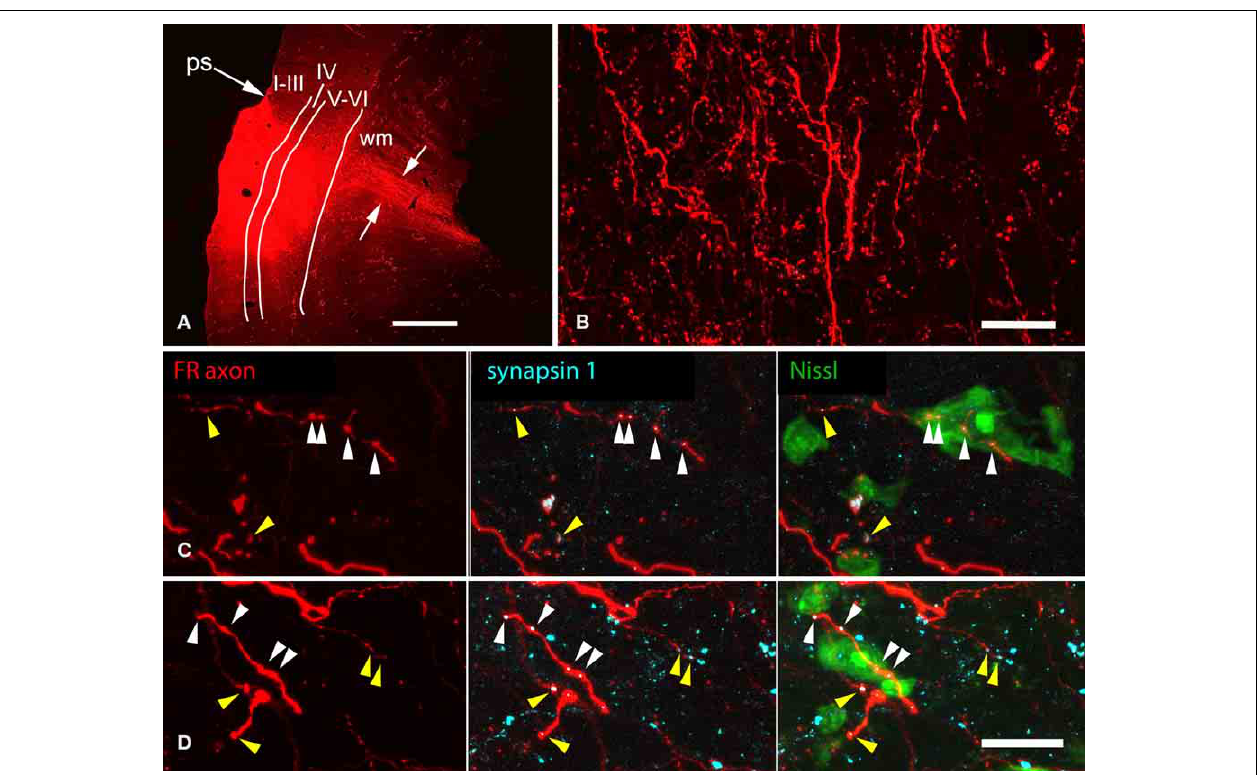
FIGURE 4 | Photomicrographs showing representative results after an injection of FluoroRuby (FR) into the left auditory cortex. (A) Transverse section showing part of a large deposit of FR into the left auditory cortex. The deposit site (bright red area) was confined to the cortical layers (indicated by Roman numerals); FR-labeled axons (between white arrows) are seen extending into the subcortical white matter (wm). GP724. ps, pseudosylvian sulcus. Dorsal is up; lateral is to the left. Scale bar = 1mm. (B) FR-labeled axons in the nucleus of the brachium of the inferior colliculus (NBIC) after the injection shown in panel (A) labeled axons as well as many boutons are visible. Sagittal section. Scale bar = 20 µ m. Structured illumination image stack; maximum projection image.